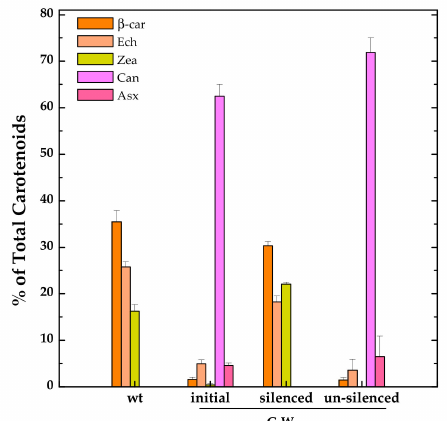
Figure 5. Relative distribution of the main carotenoids in the C-W strain constitutively expressing Brevundimonas CrtW shortly after its generation (“initial” phenotype), after several months of continuous sub-culturing in fresh medium (“silenced” phenotype) and grown to late stationary phase (“un-silenced” phenotype). Also shown is the carotenoid pattern of an exponentially growing wild-type (wt) culture for comparison. Ech, echinenone (peach); Zea, zeaxanthin (yellow); Can, canthaxanthin (light magenta); Asx, astaxanthin (pink). Error bars indicate